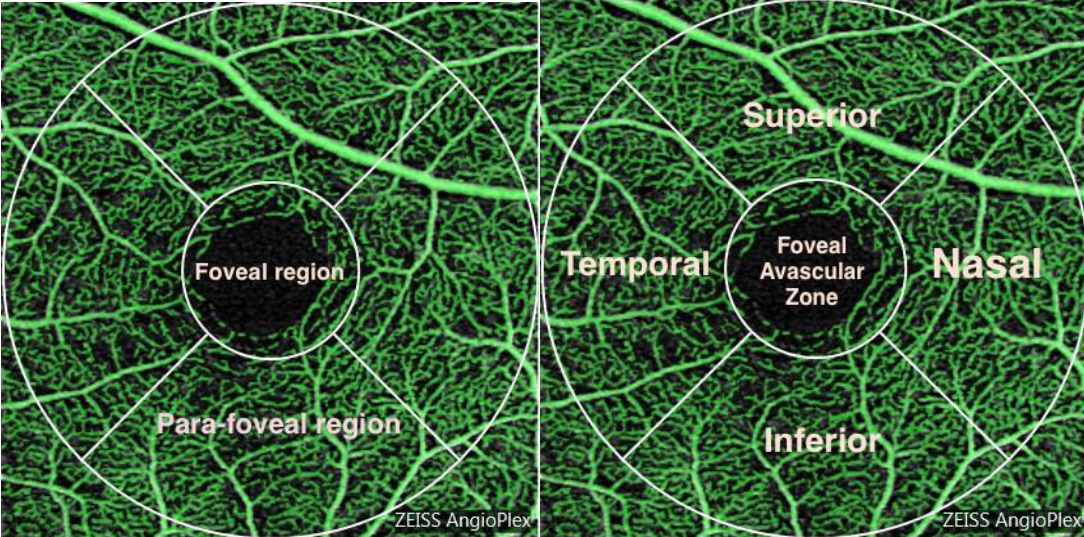
Figure 1. Pictorial representation of the macular vasculature. The vessels in a 3 mm radius annulus centred at the fovea were measured. Division of the annulus into foveal and para-foveal regions is shown along with further division into superior, inferior, nasal and temporal quadrants. The radius of the aggregated foveal / parafoveal region is 3 mm whilst the foveal region has a 1mm